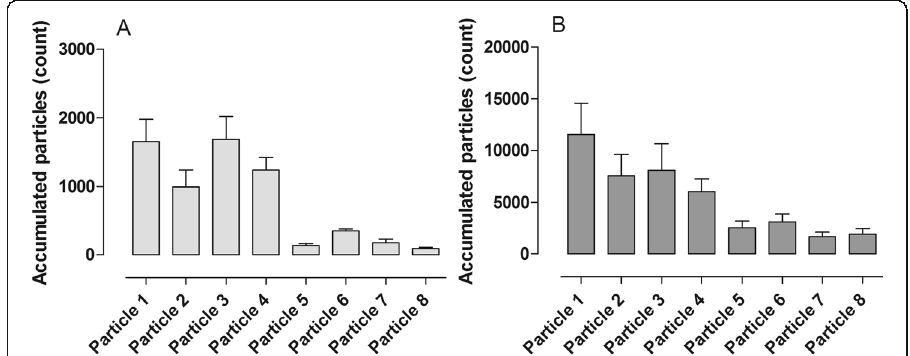
Fig. 3 Distribution of different particle sizes during different ventilation modes in vivo. a Volume-controlled ventilation (VCV) and b pressure-controlled ventilation (PCV). Note the differences in the total amount of particle count in the two different ventilation settings; interestingly, the same particle size distribution was seen in the both